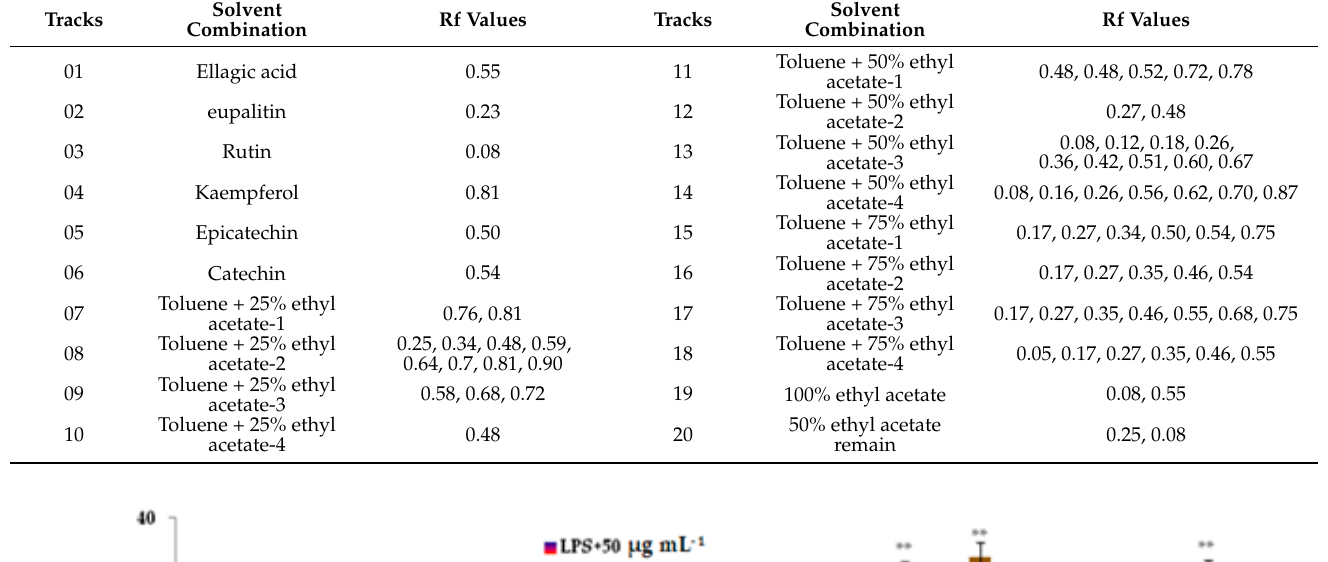
Table 3. HPTLC analyses of column eluent of ethyl acetate fractions of P. maderaspatensis using VLC.